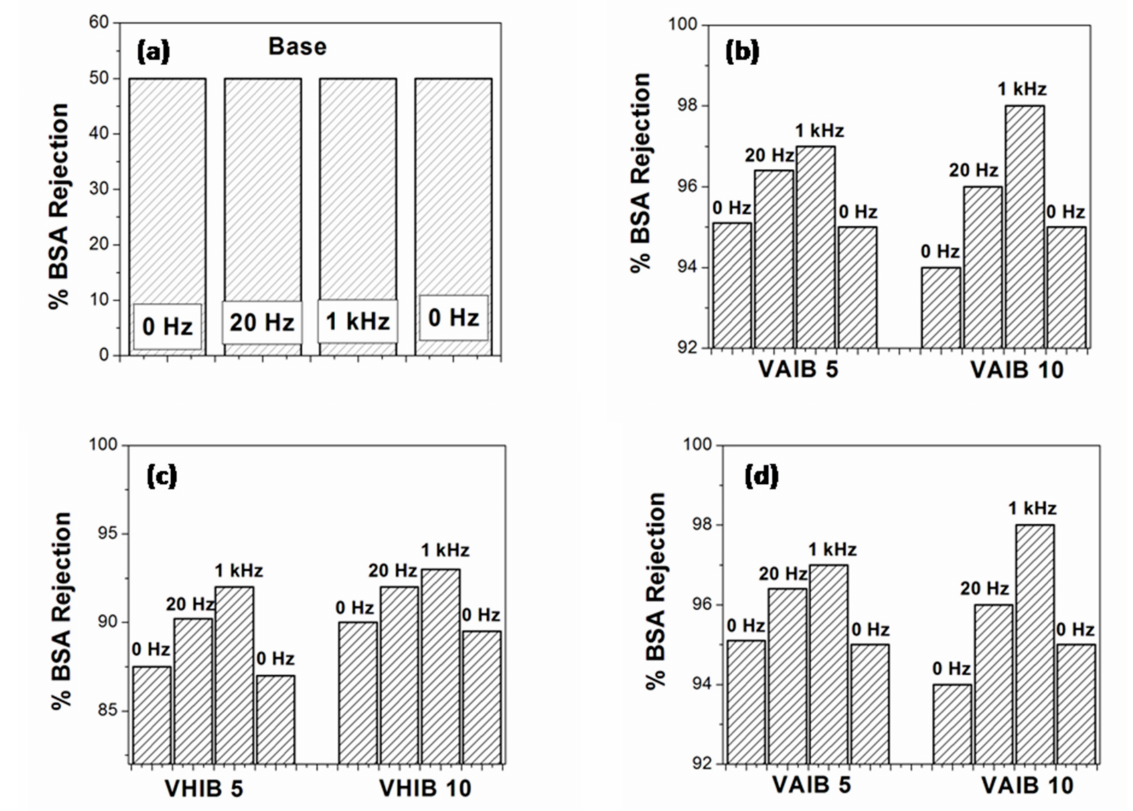
Figure 7. The rejection of BSA at various oscillating electric field frequency for the responsive membranes. ( a ): Virgin RCUF membrane; ( b ): Responsive membranes originated from vinyl allyl imidazolium bromide; ( c ): Responsive membranes originated from vinyl hexyl imidazolium bromide; ( d ): Responsive membranes originated from vinyl butyl imidazolium